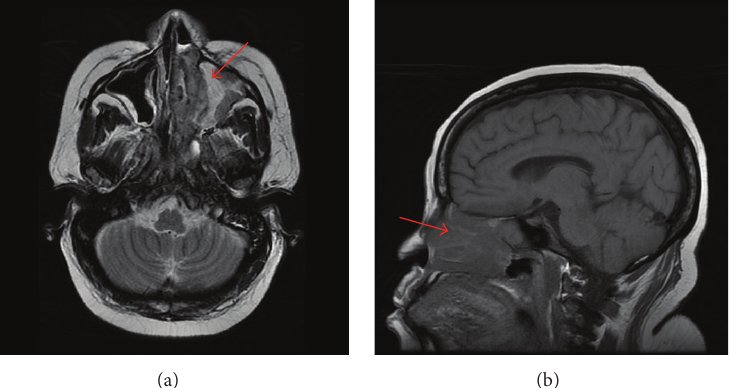
Figure 2: ((a) (axial) and (b) (sagittal)) MRI of the brain showing a soft tissue mass in the left maxillary sinus and left nasal cavity with extension to involve the medical left